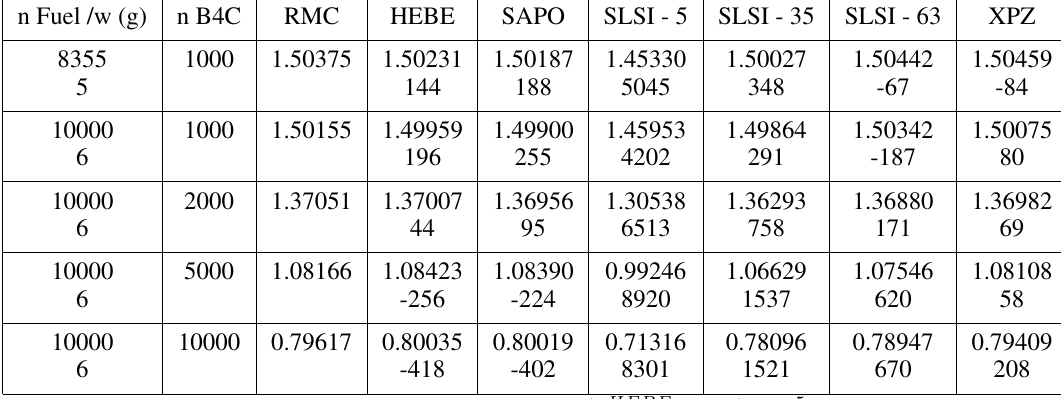
Table 2: k for fuel pebbles with several amounts of B ∞ n Fuel /w (g)